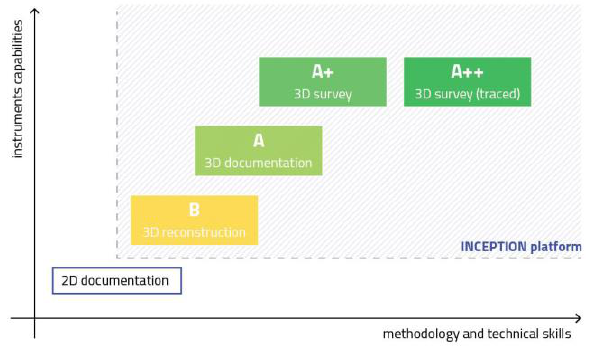
Figure 4. Evaluation